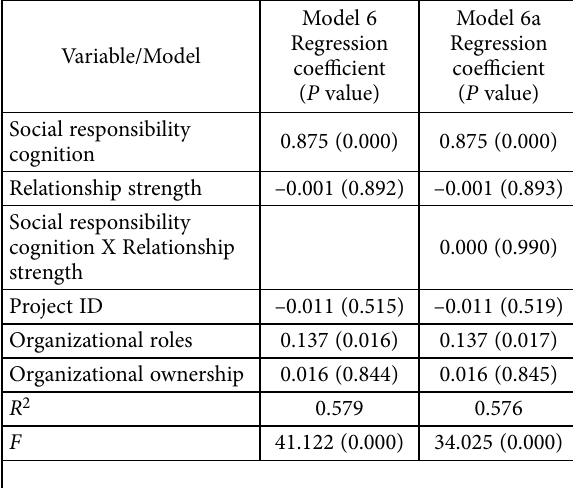
Table 10. Regression results for Model 6